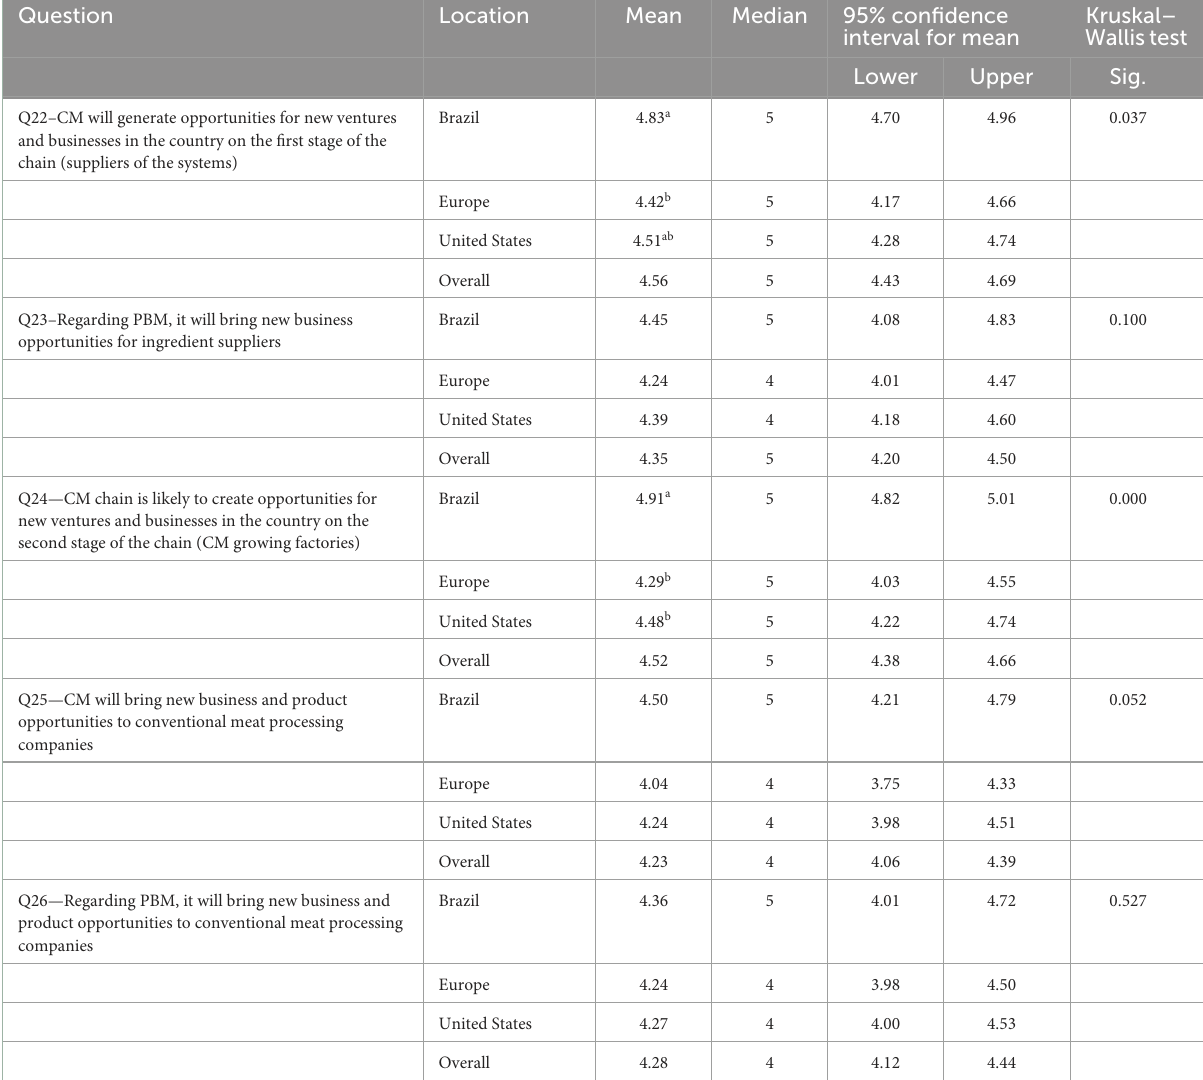
TABLE 6 Analysis for Q22–Q26 regarding business opportunities along the new chain in Brazil ( N = 35), Europe ( N = 56), and the United States ( N = 45) using Likert scale from 1 (strongly disagree) to 5 (strongly agree), as per interviews from August to October, 2021. Question Location Mean Median 95% confidence